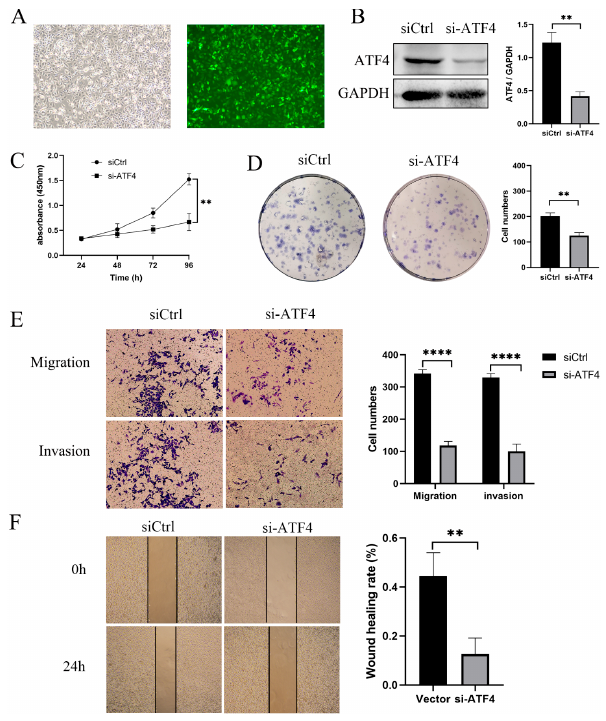
Figure 2. ATF4 knockdown strongly inhibits the proliferation and invasion of GC cells. ( A ) The lentiviral vector contains the green fluorescent protein sequence, and successfully transfected cells will express the green fluorescent protein. ( B ) Compared with cells transfected with empty vector, the expression of ATF4 in cells transfected with knockdown of ATF4 was significantly reduced. ( C , D ) CCK8 and colony formation assay were used to assess whether ATF4 affects the proliferation of the AGS cell. The results showed that compared with the control group, the proliferation rate of cells after knocking down ATF4 was significantly reduced. ( E , F ) MGC803 cells overexpressing ATF4 have improved abilities for migration and invasion, ( E ) light microscopy (×20), ( F ) light microscopy (×10). ** p < 0.01, and **** p < 0.0001. The original western blot figures could be found in Supplementary S2.